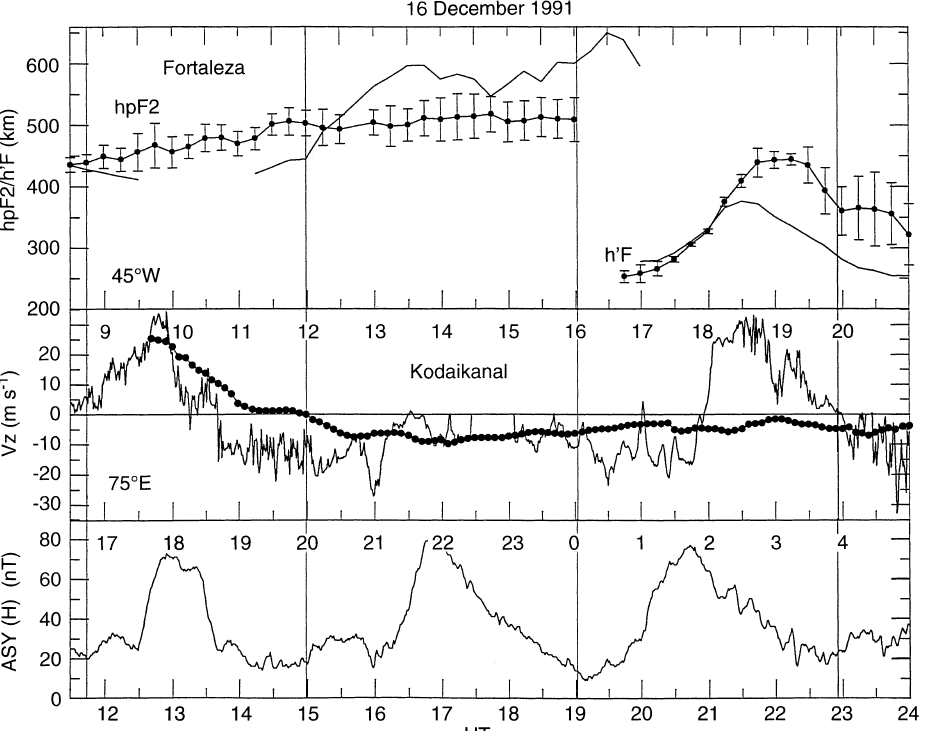
Fig. 2. Time variation of ASY( H ) index, F-region vertical plasma drift, V over Kodaikanal z (dip 4), India and hpF2/h (cid:162) F at Fortaleza (dip ) 9), Brazil on 16 December 1991. The curves with solid circles represent the average quiet-day patterns of the param- eters at the two stations. The vertical bars represent standard deviations of the average values of hpF2 and h (cid:162) F